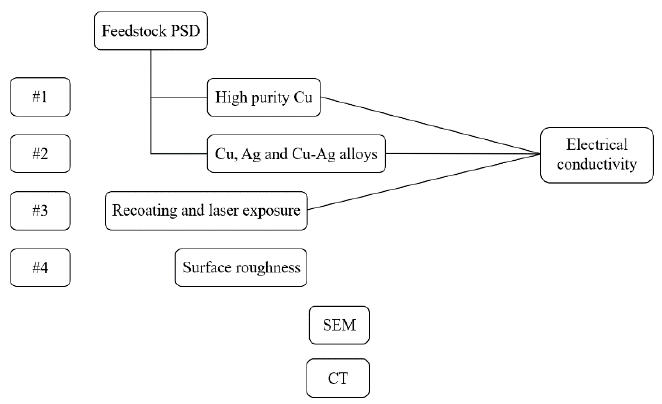
Figure 1. Schematic illustration of investigations conducted.